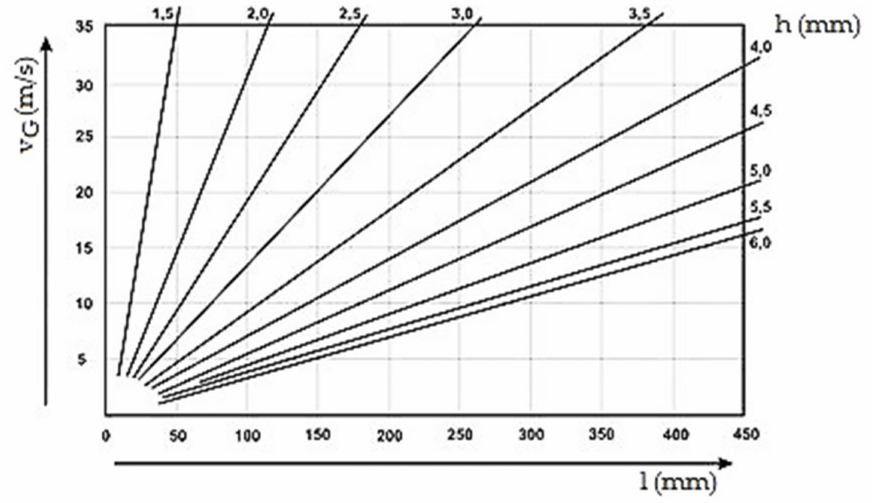
Figure 2. Speed of flow v G inside the gate (Gate velocity) dependence on the wall thickness h of a cast and in dependence of maximum distance l mold on gate.